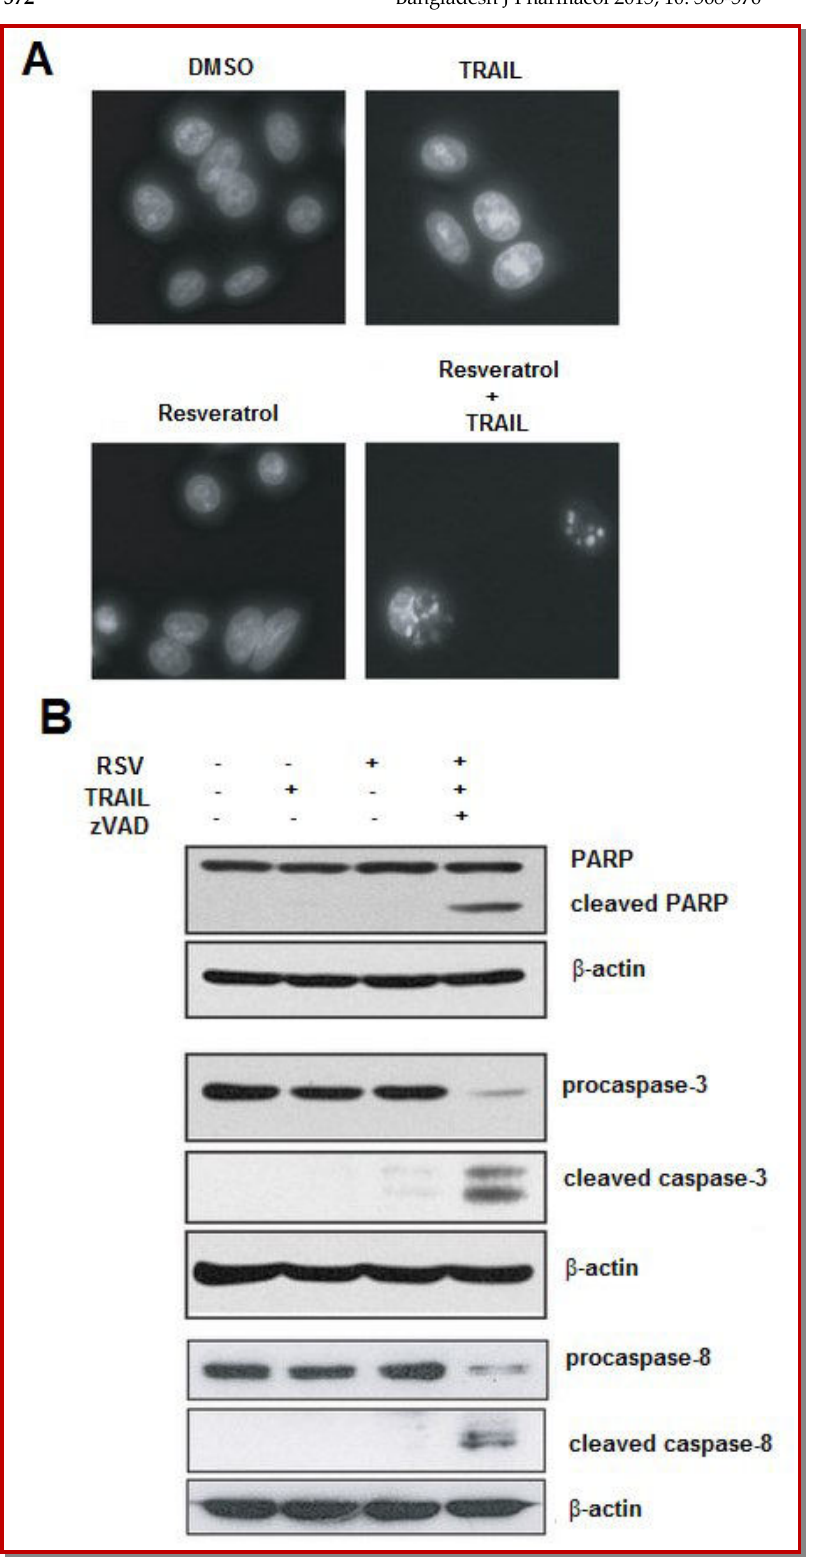
Figure 3: The combination of resveratrol and TRAIL induces nuclear condensation and fragmentation and cleaves caspases and a substrate of caspases PARP. (A) Nuclei in cells stained with DAPI. Caco cells were treated with 20 ng/mL of TRAIL and/or 40 µM resveratrol. (B) Western blotting of PARP, caspase-3, and -8. β -actin is a loading control. (-, no treatment; DM, solvent DMSO treat-